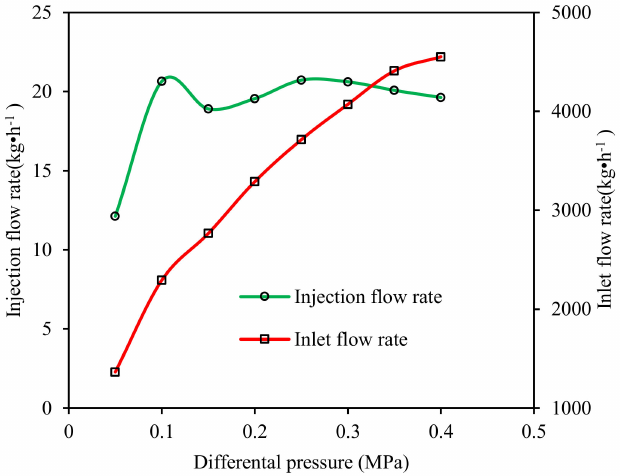
Figure 4. Influence of di ff erential pressures on Q il and Q ij